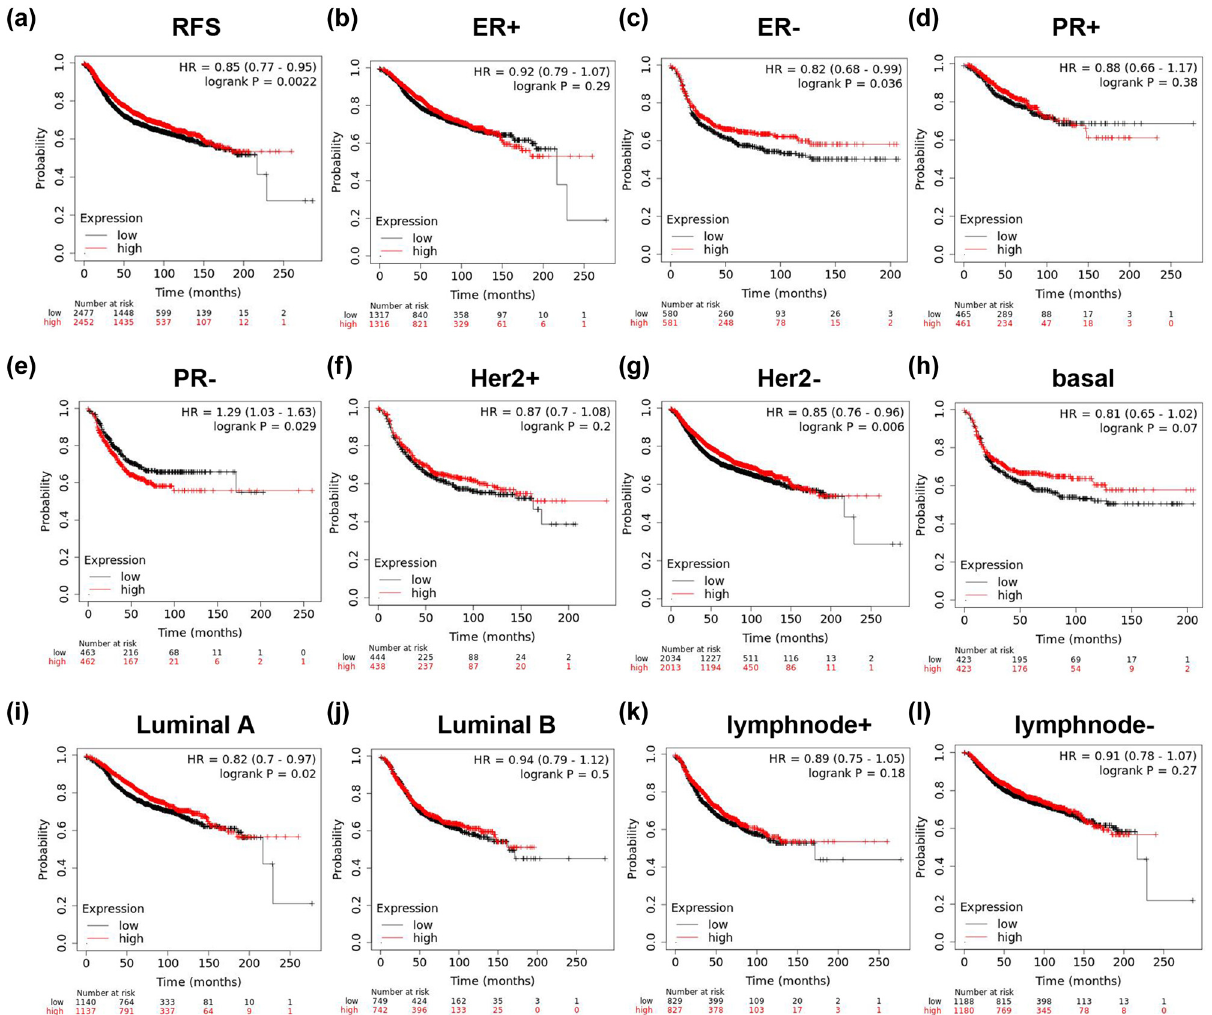
Figure 4: Analysis of the prognostic value of LIG3 in BC. The correlation of LIG3 expression with relapse free survival was analyzed by the Kaplan – Meier plotter in ( a ) all patients with breast cancer, and various subtypes of BC, including ( b ) ER - positive, ( c ) ER - negative, ( d ) PR - positive, ( e ) PR - negative, ( f ) Her2 - positive, ( g ) Her2 - negative, ( h ) basal - like, ( i ) luminal A, ( j ) luminal B, ( k ) lymphnode - positive and ( l ) lymph node -